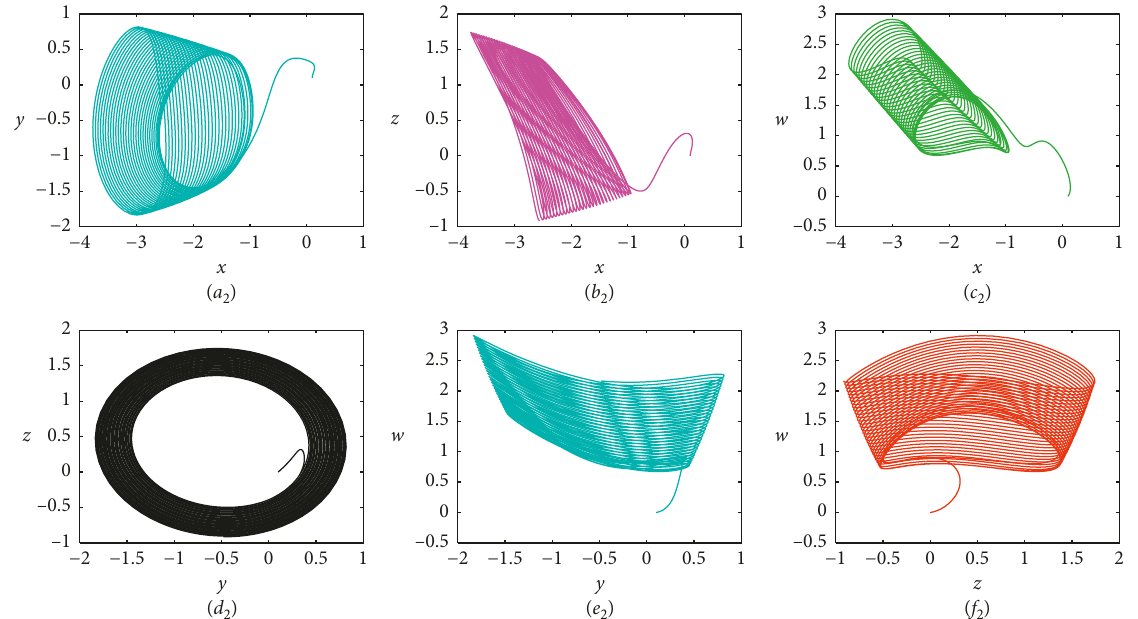
Figure 12: Phase portraits of Experiment 2 with a � 0 . 1 , t � 100: ( a ) on y − w plane; ( f plane; ( e 2